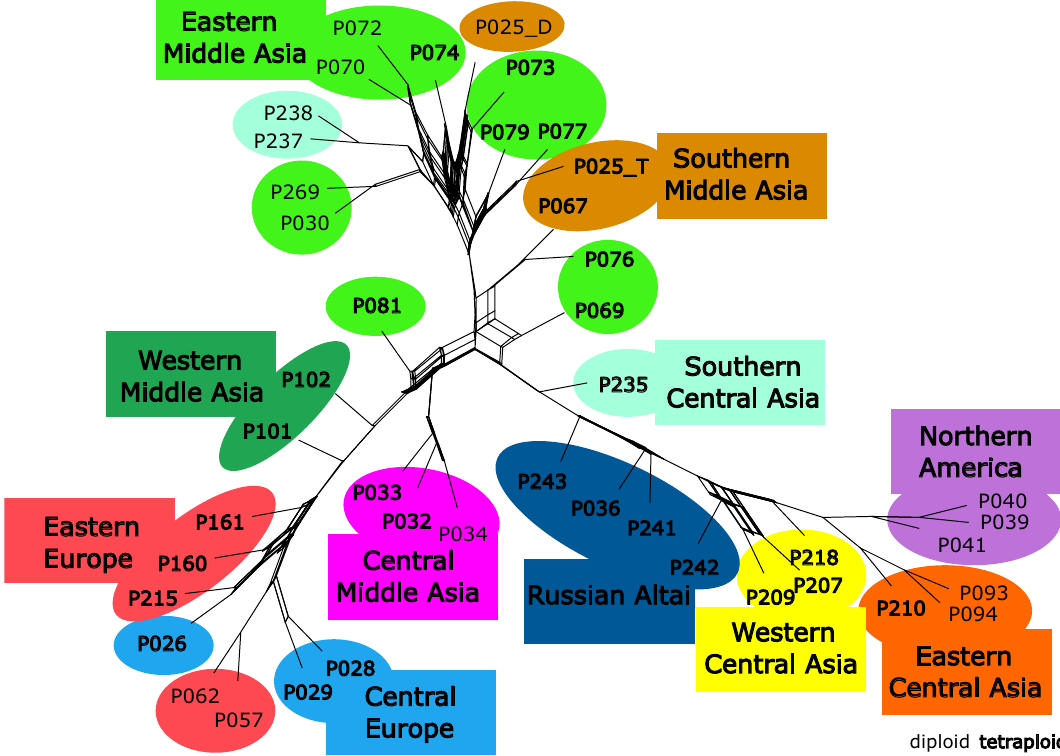
Figure 6. Phylogenetic network based on a ML method (IQ-TREE). The origin of the populations is indicated by colour (compare Fig. 1). Tetraploids are shown in bold. The network was visualized in SplitsTree and edited in Inkscape v1.0.2 (https:// inksc ape.